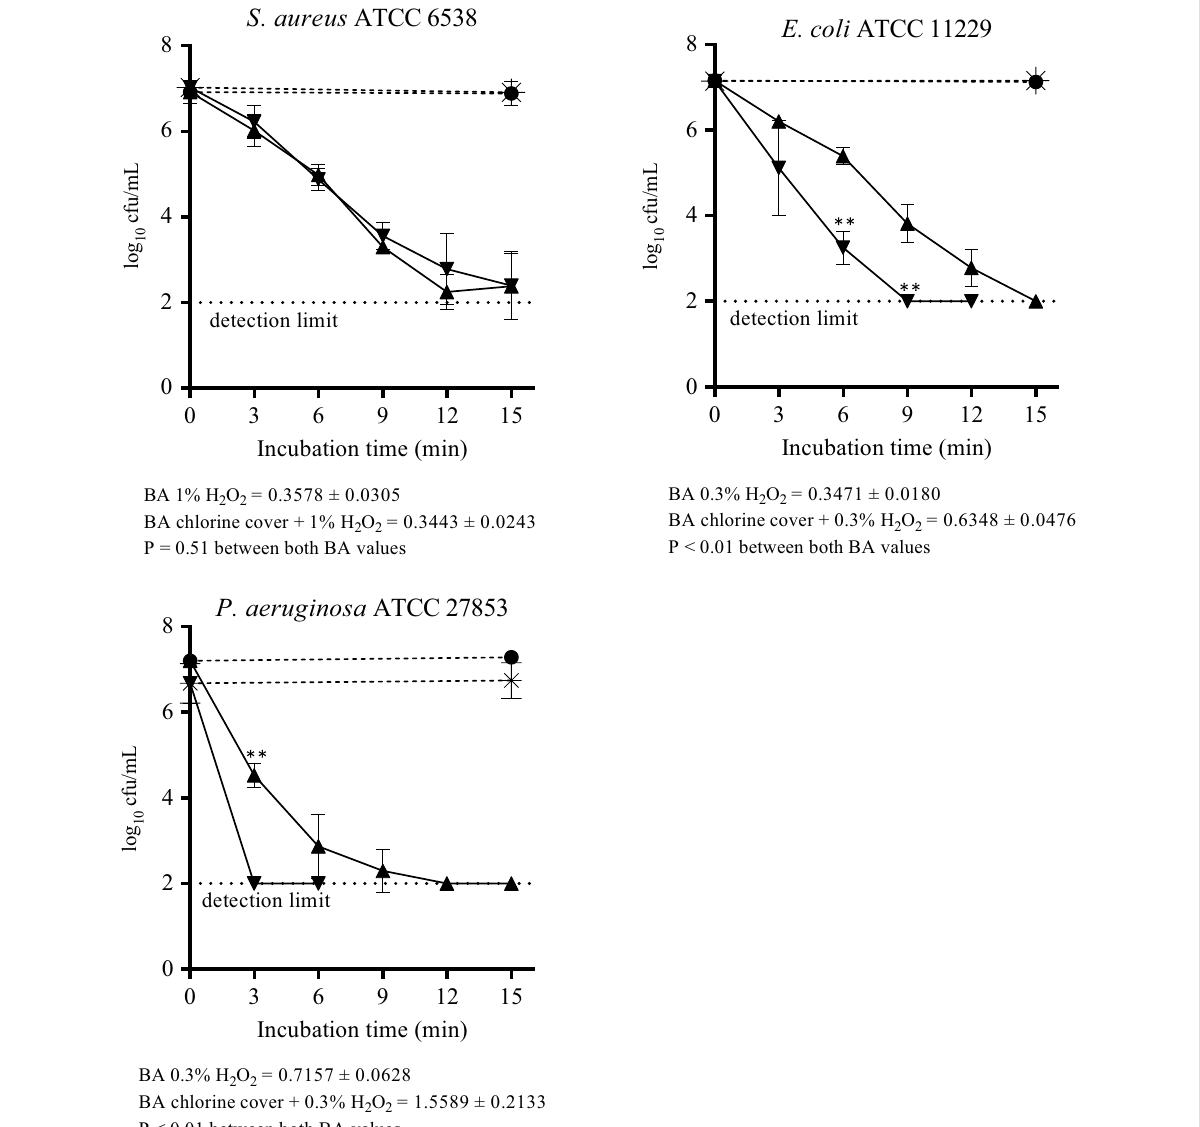
Fig. 8 Bactericidal activity of H 2 O 2 ( filled triangle ) and of H 2 O 2 against chlorine-covered bacteria that were pretreated with 1% NCT for 1 min ( inverted triangle ). 1% H 2 O 2 against S. aureus ATCC 6538, 0.3% H 2 O 2 against E. coli and P. aeruginosa . Controls in phosphate buffer without additives, without ( filled circle ) or with chlorine cover ( Asterisk ). Mean values SD of three to four independent experiments. ** P < 0.01 versus all other values. ± BA values calculated as in Fig.